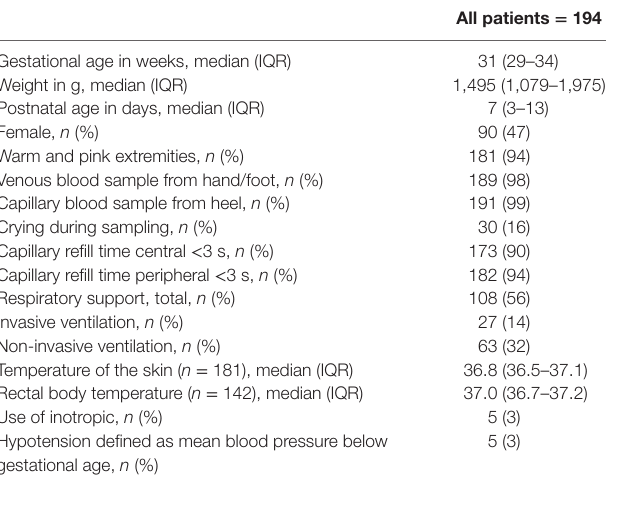
TaBle 1 | Patient characteristics.